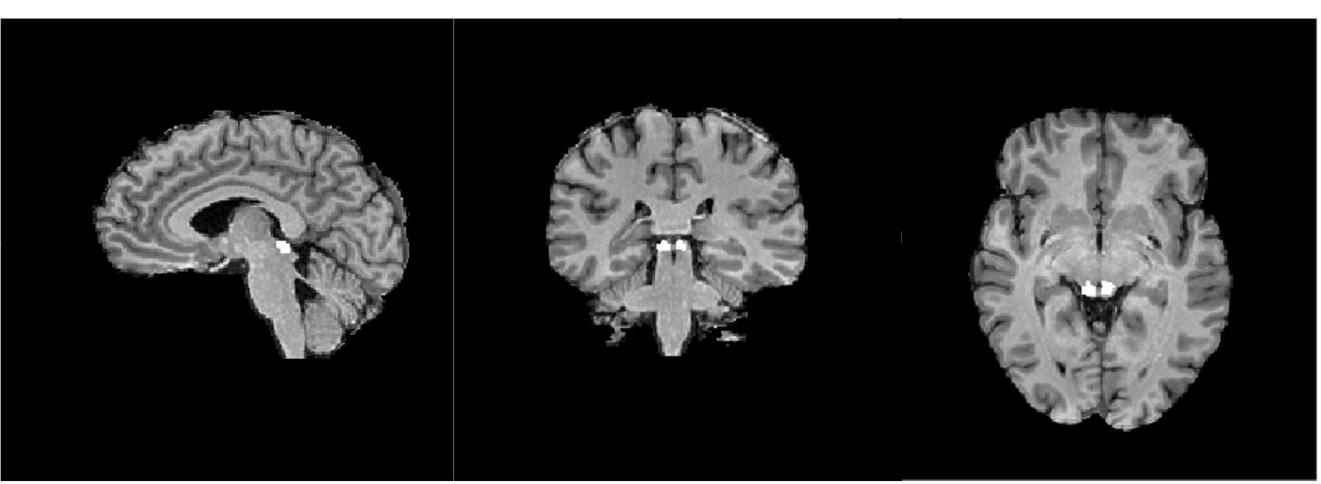
Fig 7. Locations of the anatomically defined left and right SC ROIs in one representative subject.